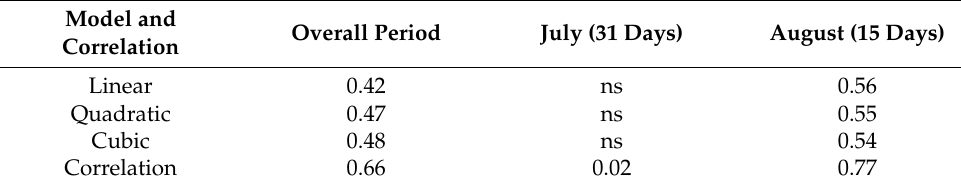
Table 4. Adjusted coefficients of determination for regression equations and correlation values for observed daily water intake and net solar radiation in finishing steers with the validation dataset.